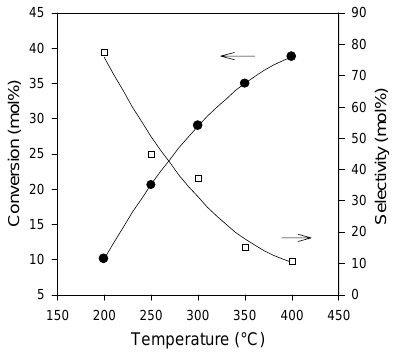
Figure 1. Activity of VS-1. O